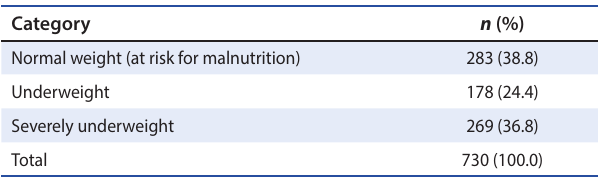
Table 1: Entry nutritional status of children receiving supplemental food at the clinics Category